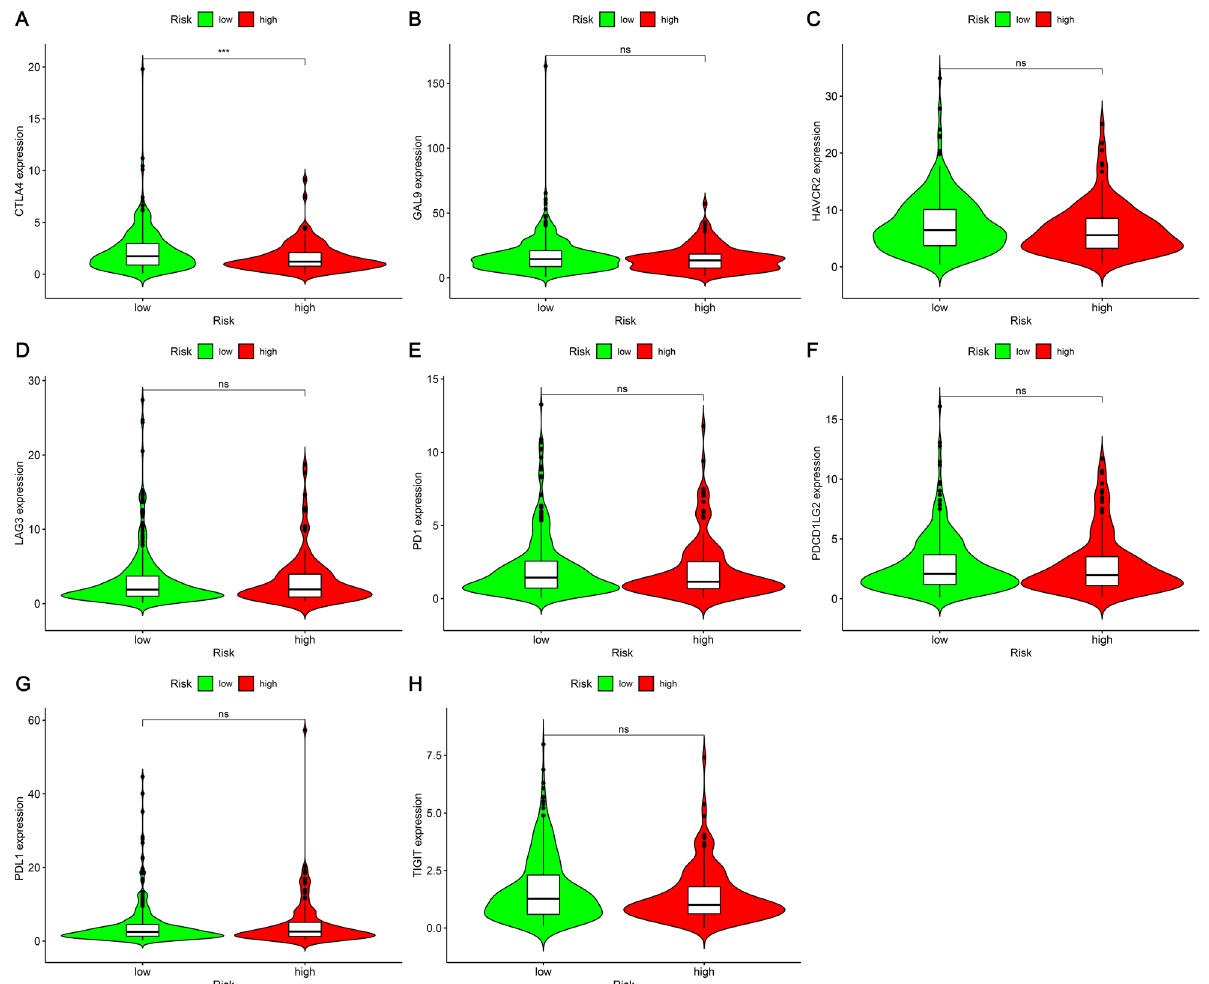
Figure 9. The relationship between LUAD patients’ genes and risk model. The levels of expression of ( A ) CTLA4; ( B ) GAL9; ( C ) HAVCR2; ( D ) LAG3; ( E ) PD1; ( F ) PDCD1LG2; ( G ) PDL1; ( H ) TIGIT in high-risk and low-risk LUAD subjects. Ns not significant; ***p <